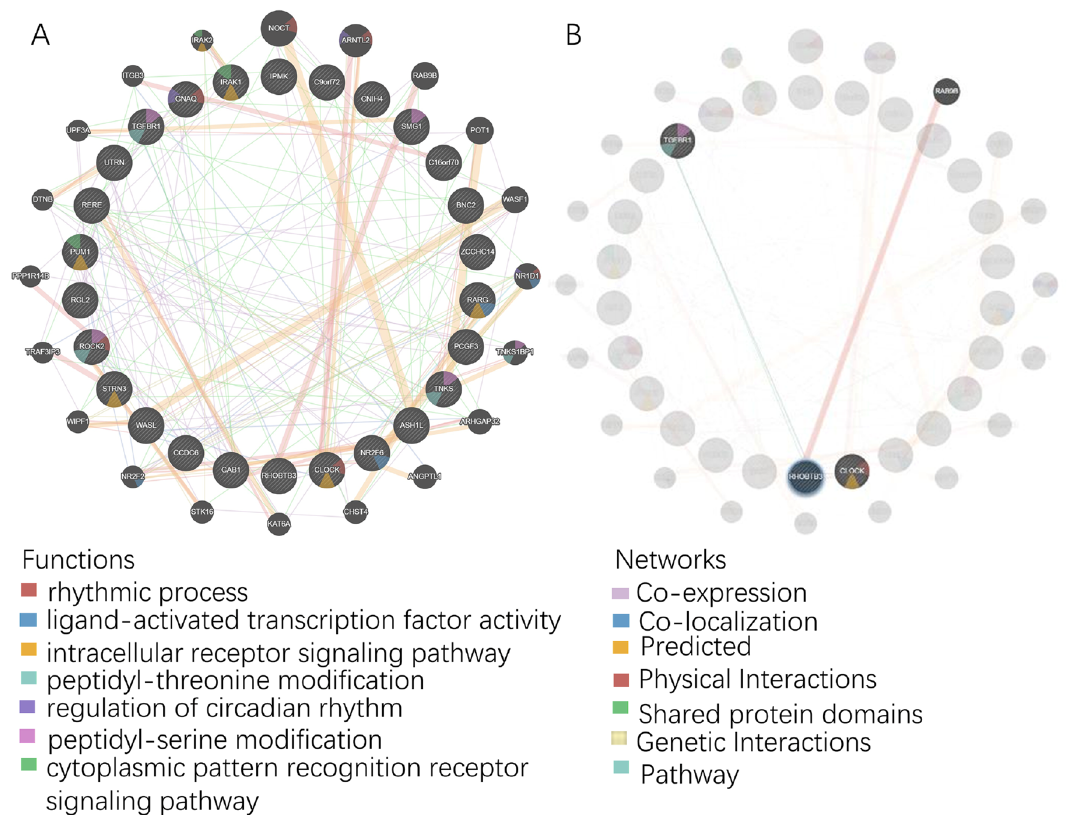
Figure 5. GENEMIA. ( A ) Predicted network of enriched terms across 26 genes which were predicted as miR- 142-3p targeted genes in all three databases; ( B ) Physical interactions of RhoBTB3 and shared protein domains with Rab9b; co-localization and genetic interactions with TGFβR1; co-expression with CLOCK. The codes can be verified from the GENEMIA database.